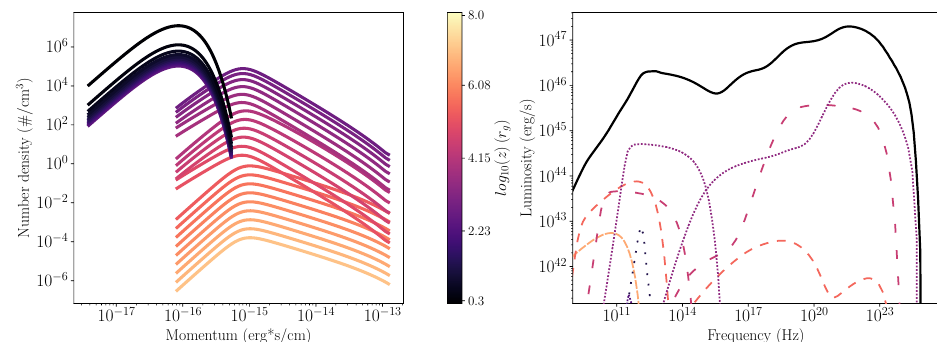
Figure 9. Electron distributions (left panel) and corresponding MWL SED (right panel) computed with BHJet at several distances along the jet axis of a FSRQ. The colored lines represent particles distributions or SEDs at different heights. The black line in the right plot represents the sum of the emission at all heights. Figure from [90], reproduced with permission of the